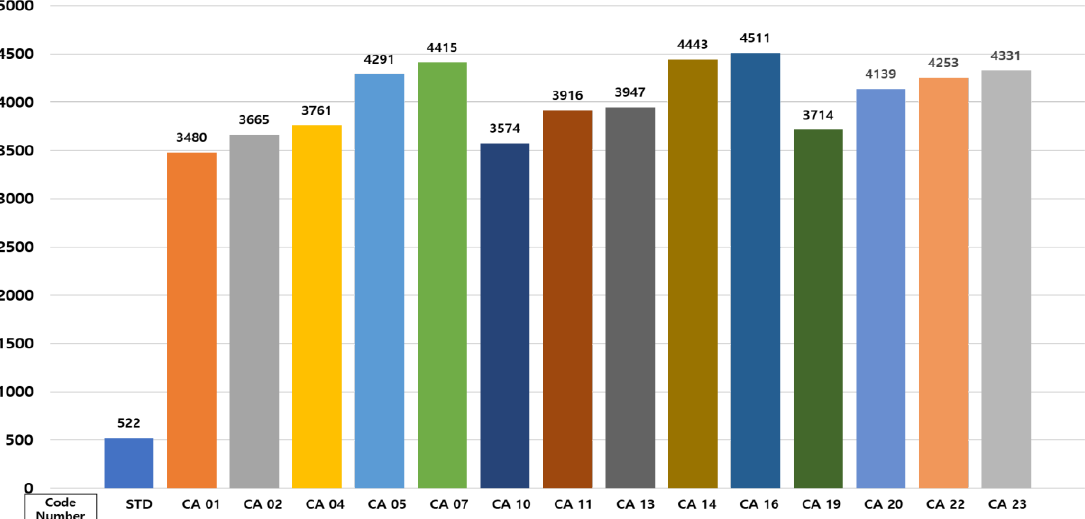
Figure 20. Composite additive viscosity test results.